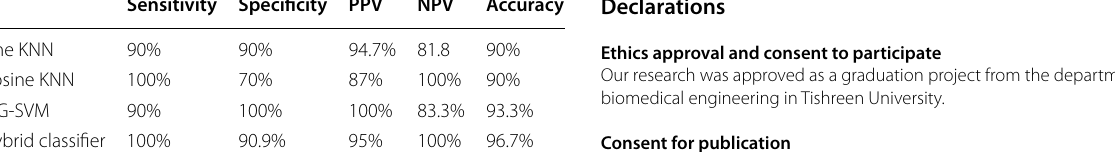
Table 1 Values extracted from confusion matrices Sensitivity Specificity